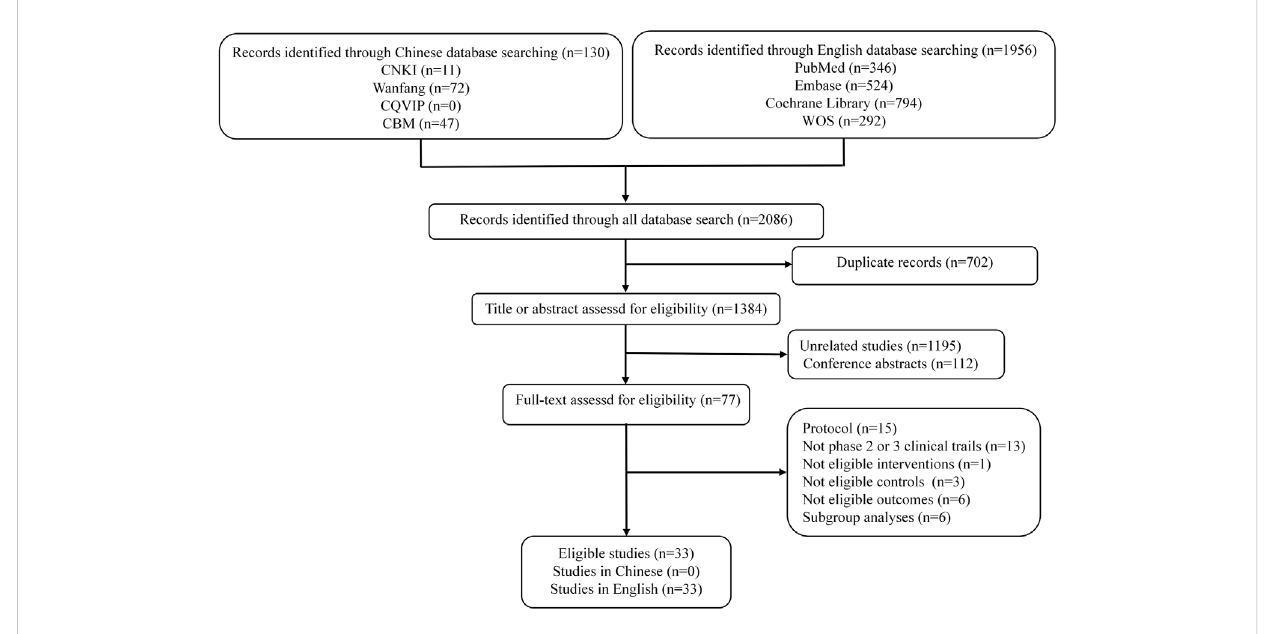
FIGURE 1 Flow diagram of study